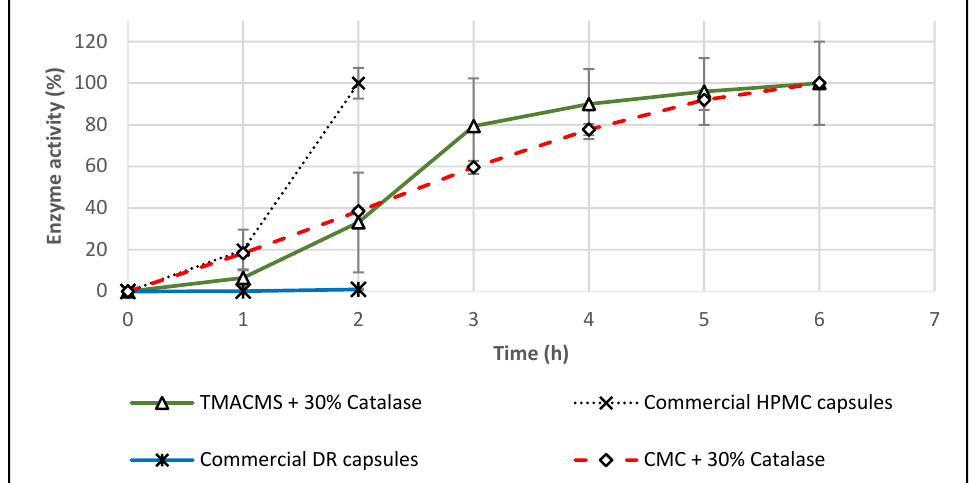
Figure 10. Release profiles of catalase from tablets based on CMC and TMACMS and from hydroxypropyl methylcellulose (HPMC) and delayed release (DR) capsules. All tests were performed in triplicate in acetate buffer, pH 4.5, at 37 °C, 50 rpm.